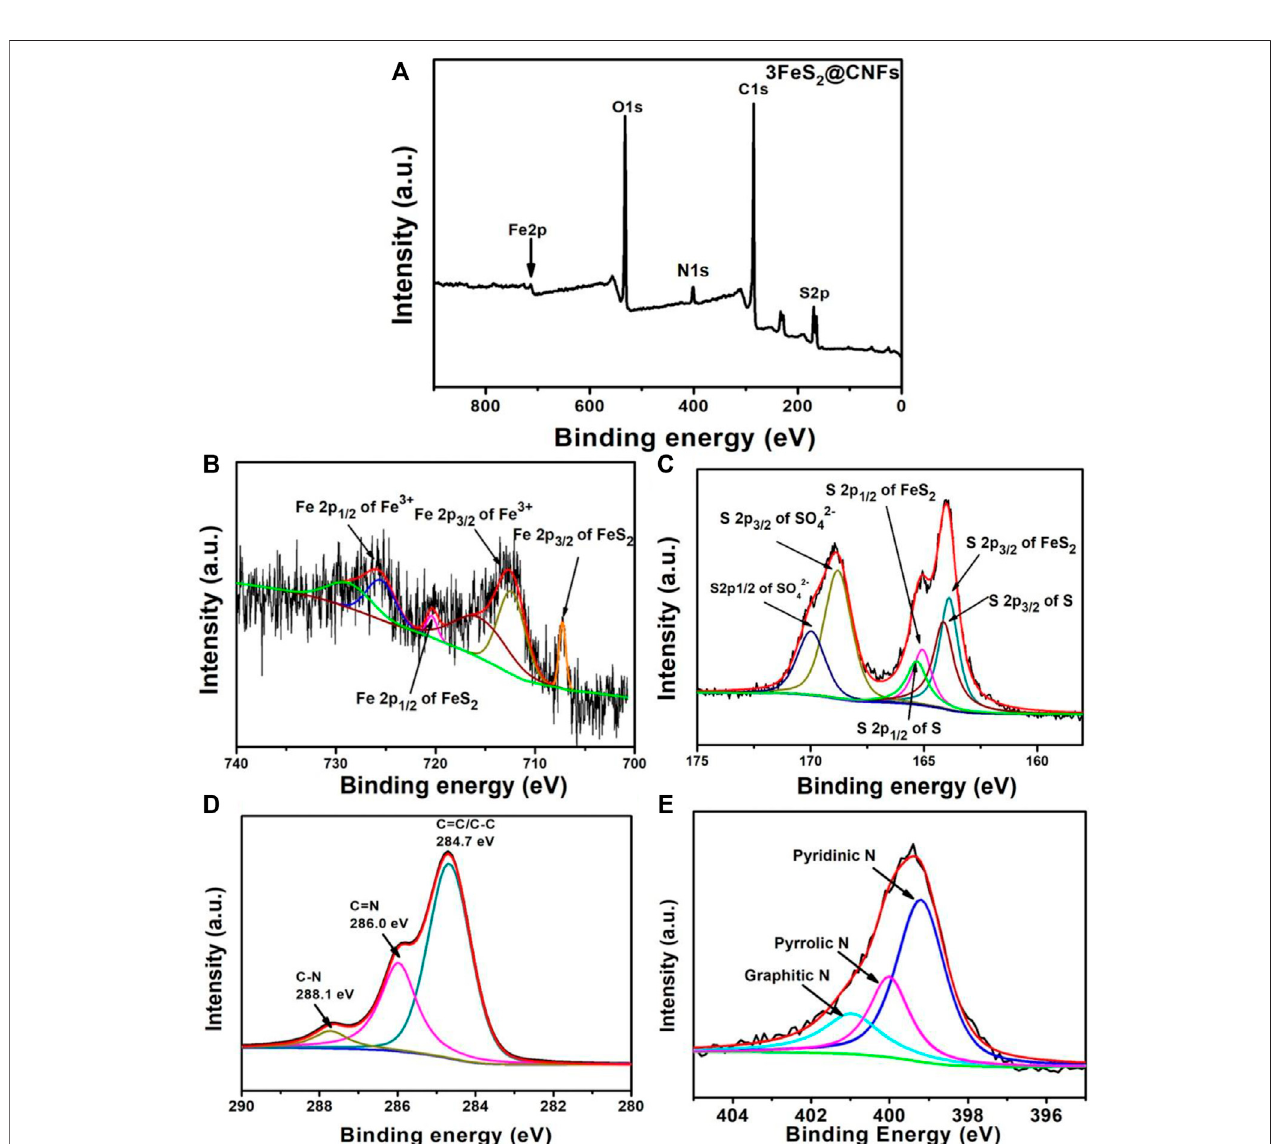
FIGURE 3 | XPS of 3FeS2@CNFs: (A) survey spectra, (B) Fe 2p, (C) S 2p, (D) C1s, and (E) N1s.